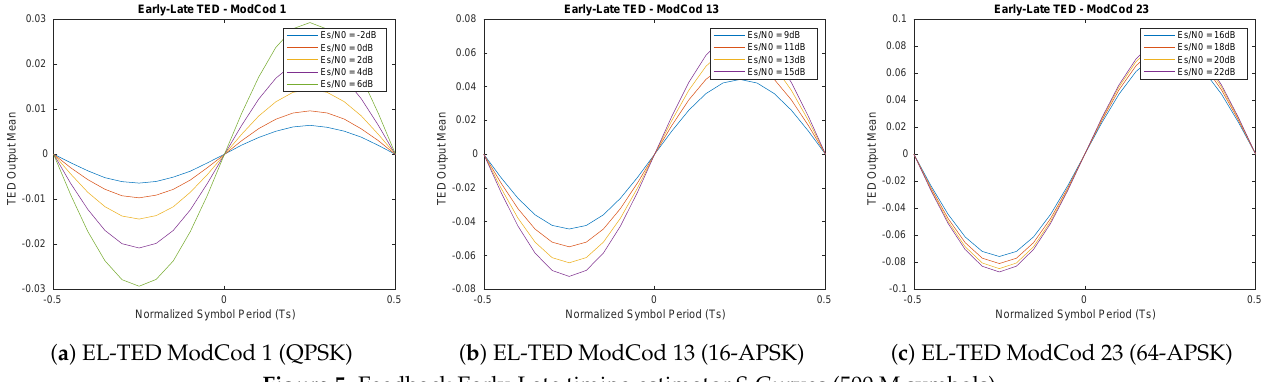
Figure 5. Feedback Early-Late timing estimator S-Curves (500 M symbols).